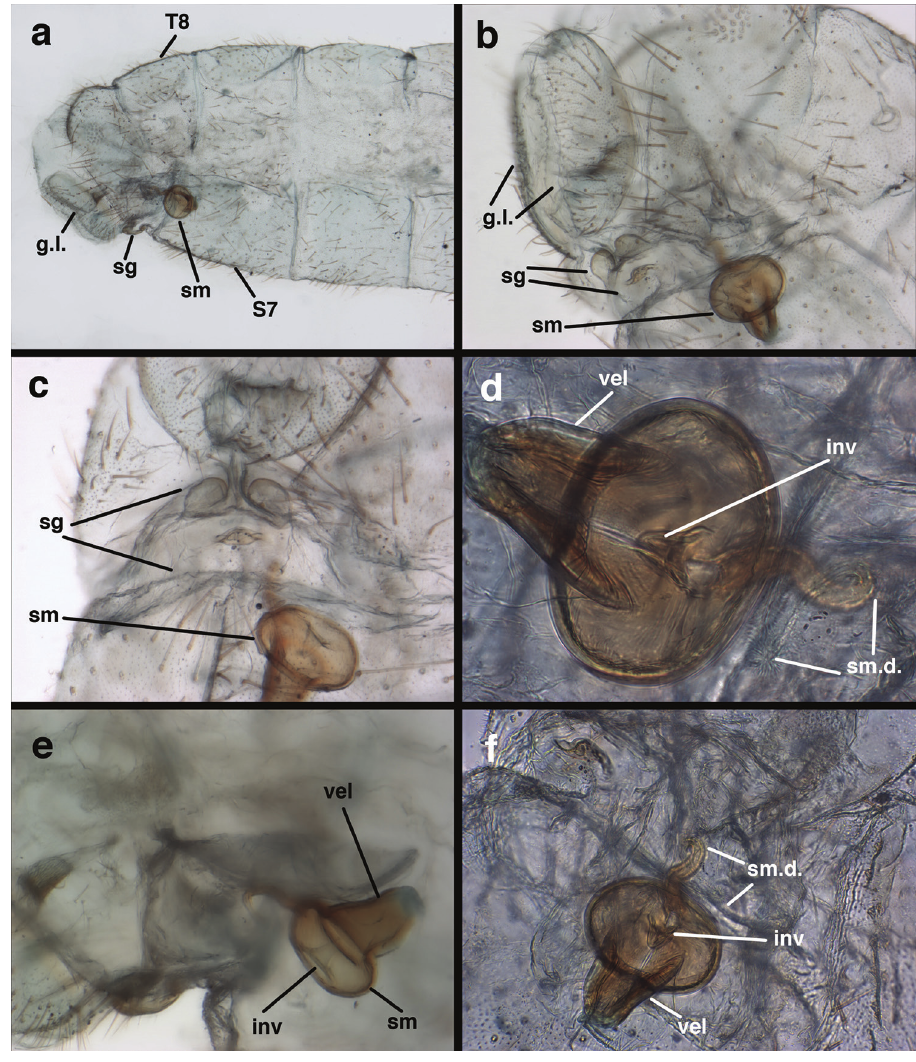
Figure 96. Ungla annulata Navás: Female abdomen and genitalia, ( a ) segments A6-terminus, lateral ( b ) terminus, ventrolateral ( c ) genital structures, ventral ( d ) spermatheca ( e, f ) spermathecal complex, in situ . g.l. gonapophysis lateralis inv spermathecal invagination sg subgenitale sm spermatheca sm.d. sper- mathecal duct S7 seventh abdominal sternite T8 eighth abdominal tergite vel velum (Argentina, Cata- marca, lectotype,